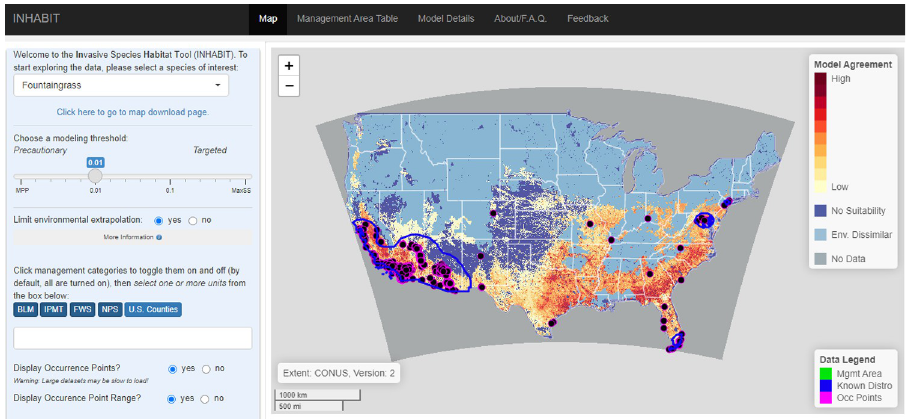
Fig 2. The layout and features of the Invasive Species Habitat Tool (INHABIT; http://gis.usgs.gov/inhabit) landing page in August 2021. The sidebar panel is visible on the left and the main panel on the top right with the “Map” tab